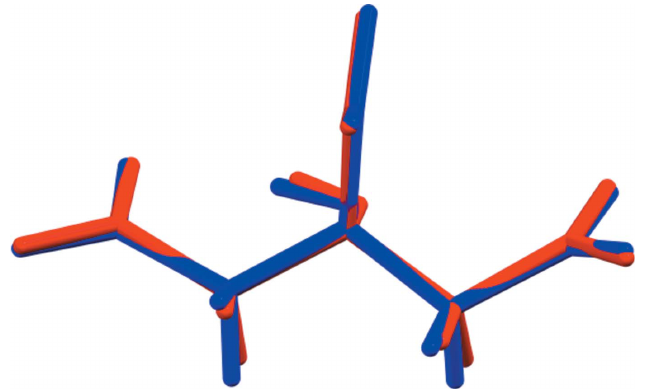
Figure 4 Comparison of the refined and optimized structures of (II): the refined structure is in red, and the DFT-optimized structure is in blue.